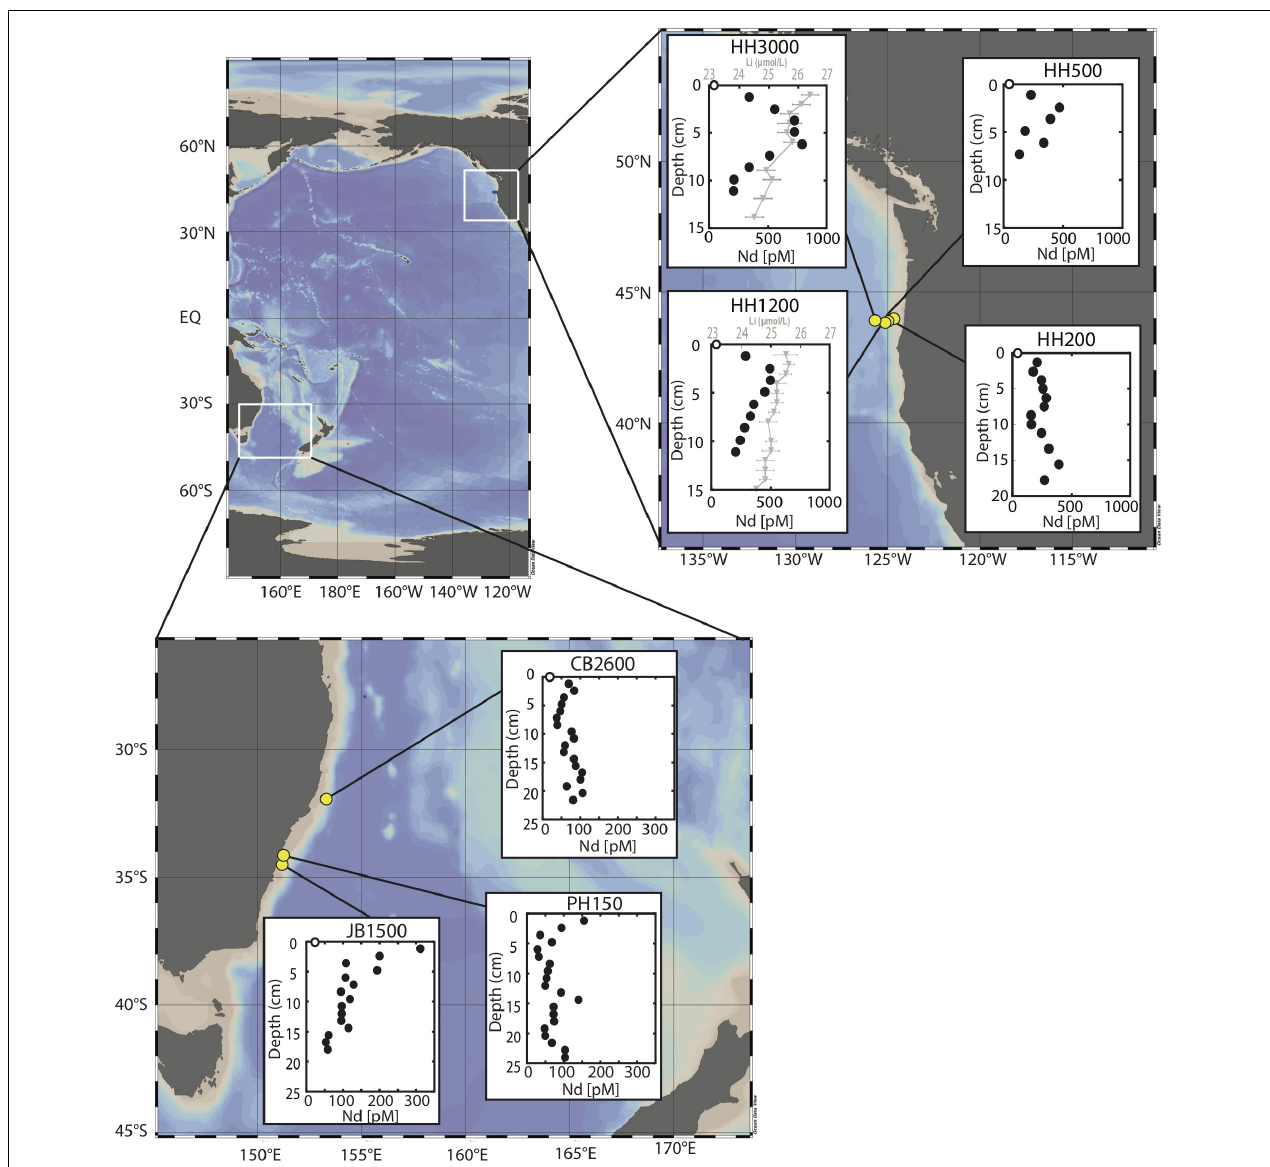
FIGURE 1 | Site locations in the North Pacific and Tasman Sea. Pore water neodymium profiles shown for each site (neodymium concentrations from Abbott et al., 2015b; Abbott, 2019). Dissolved lithium pore water profiles are provided for NP1500 and NP3000 from Abbott et al.,